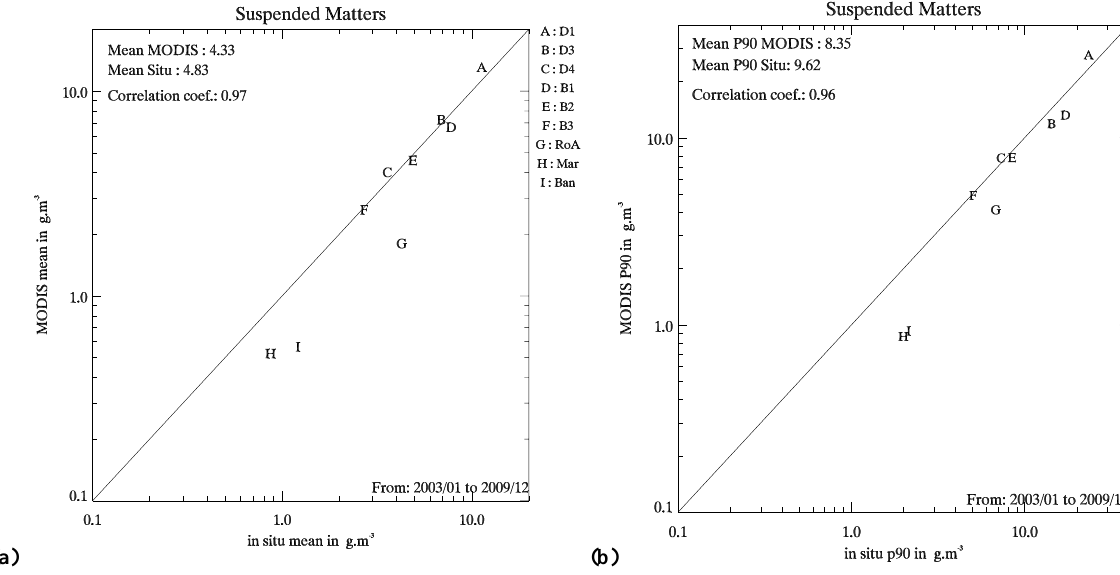
Fig. 8. Annual average (a) and P90 (b) of the MODIS and in-situ SPM.